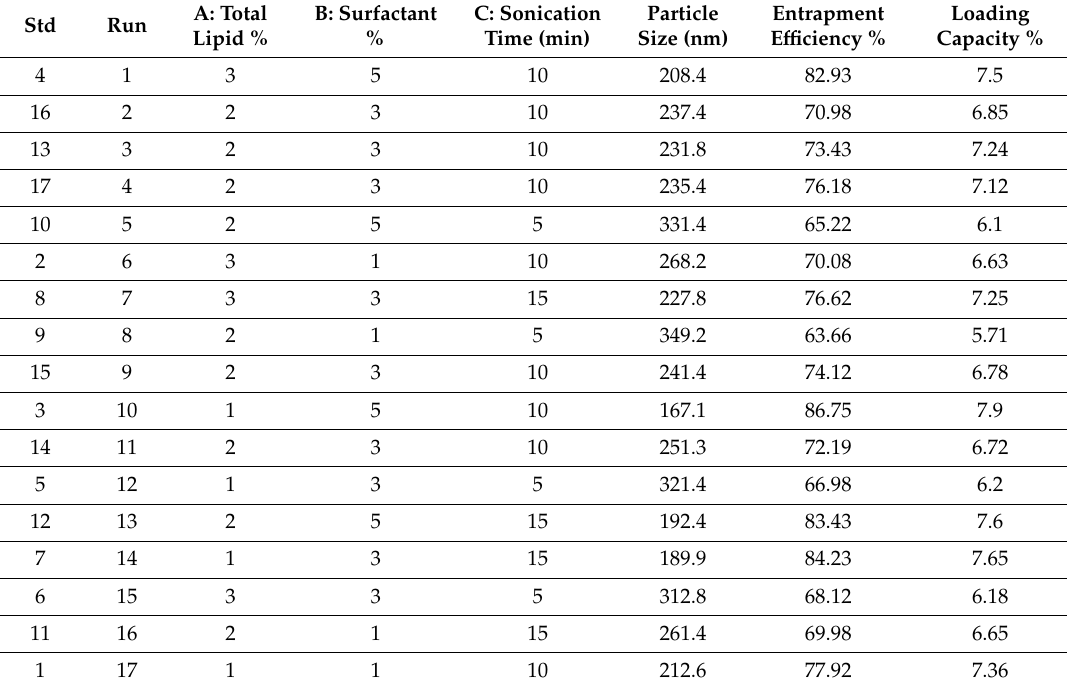
Table 4. Experimental runs designed by Box–Behnken and the obtained